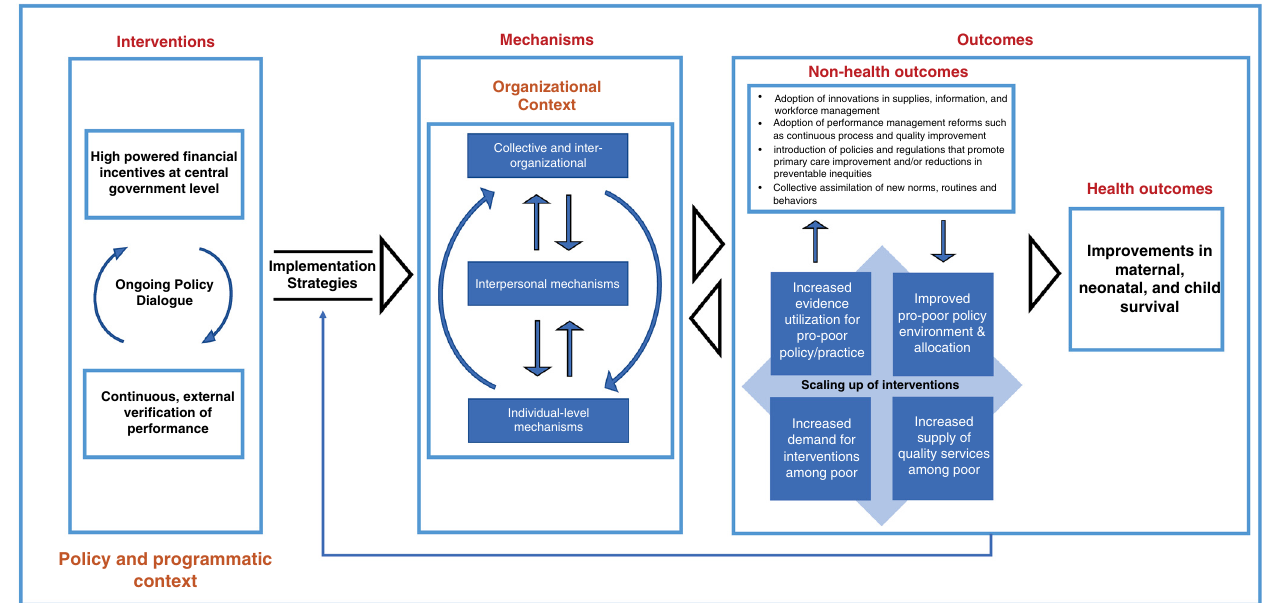
Figure 2. Preliminary program